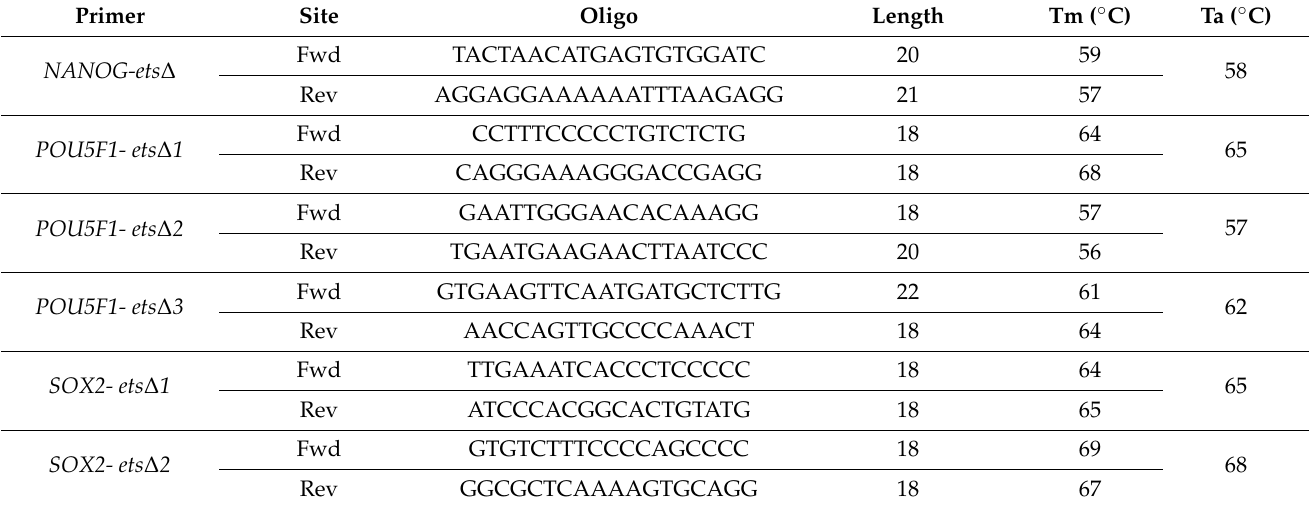
Table 4. Primers used for site-directed mutagenesis of cloned